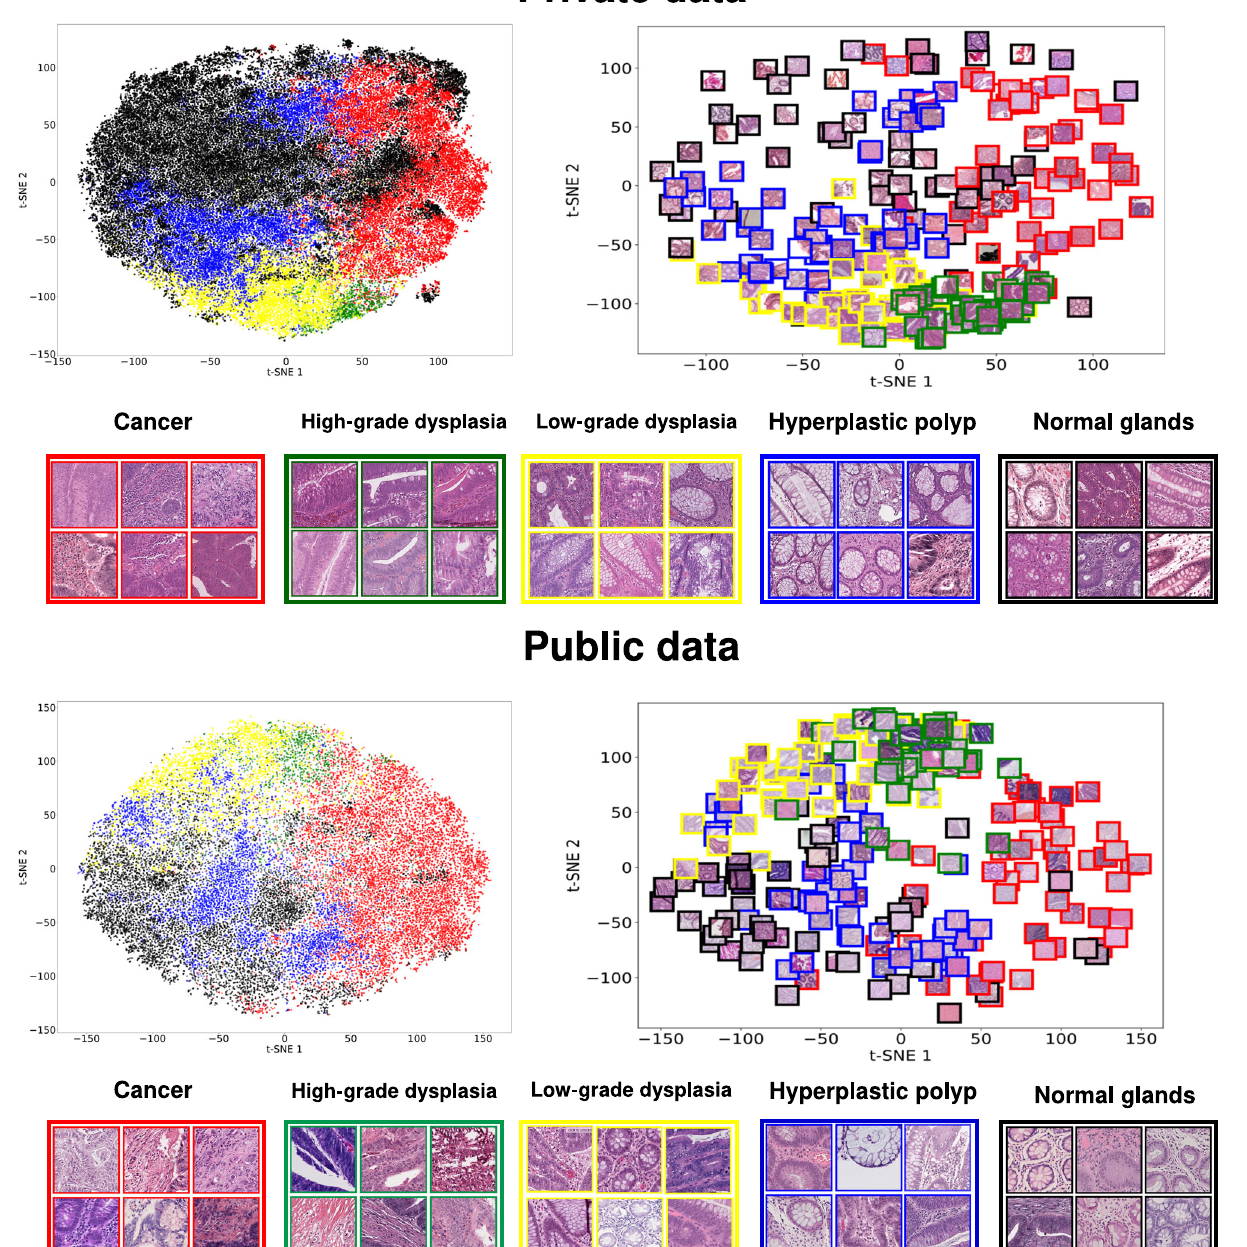
Fig. 3 Qualitative model evaluation. The graphs include the feature embedding produced by the CNN, projected in two dimensions with t- SNE, for data coming from the private test partition (Private data, above) and the publicly available datasets (Public Data). The embeddings are represented as dots on the left side of the Figure, to show the class distribution, and as randomly selected patches on the right side of the Figure. The classes are: cancer (red), high-grade dysplasia (green), low-grade dysplasia (yellow), hyperplastic polyp (blue) and normal